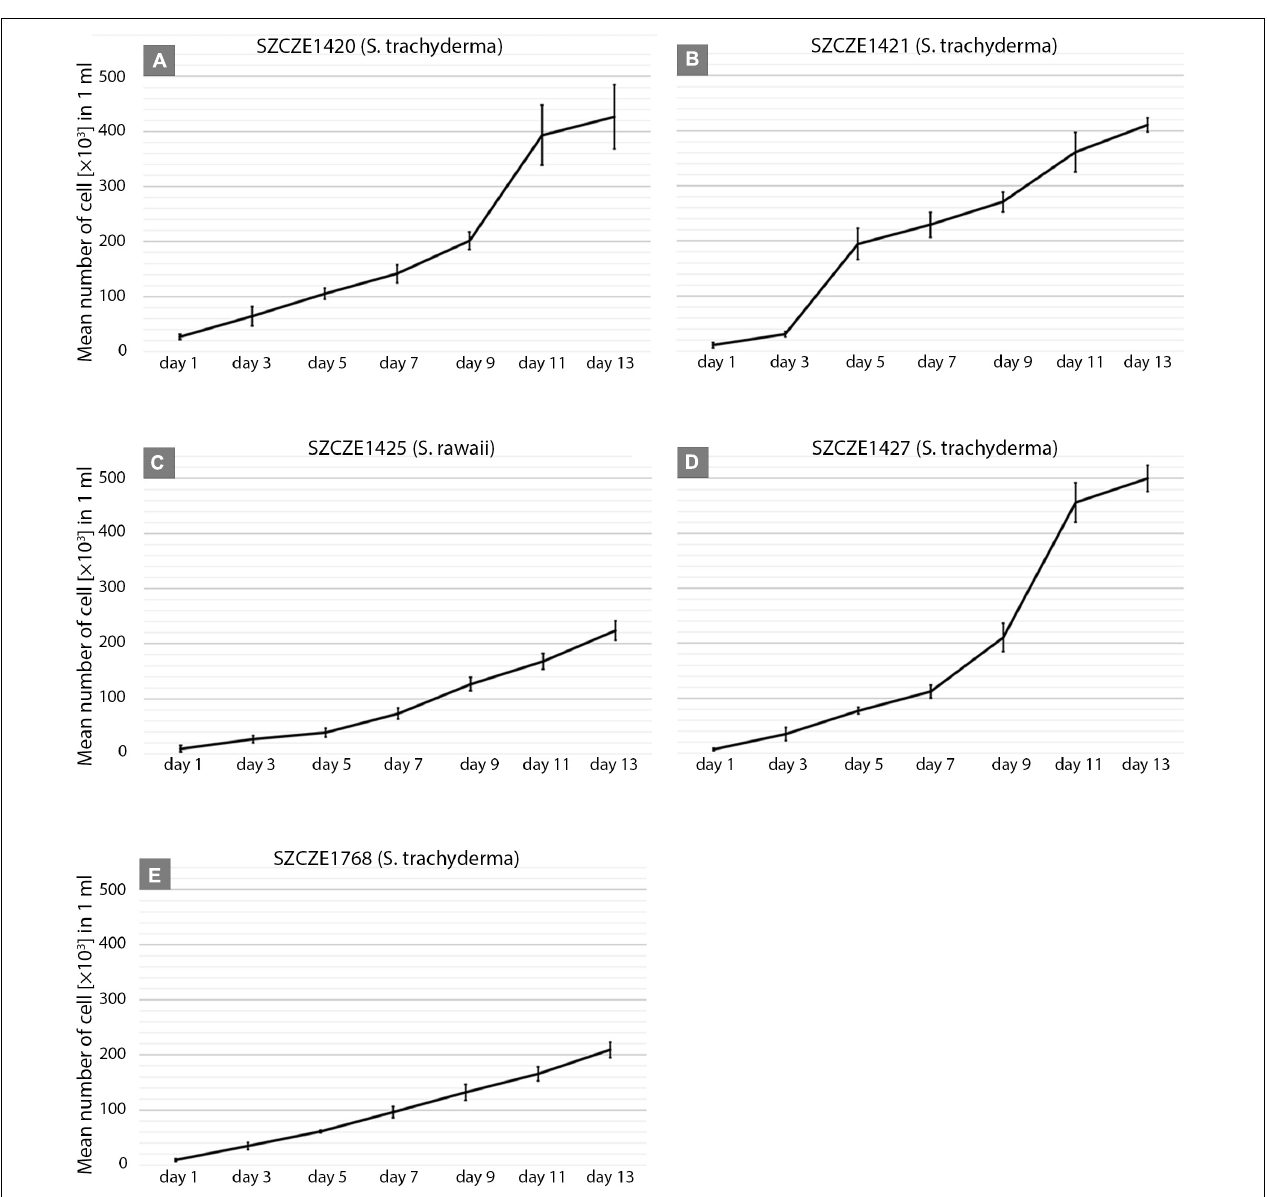
FIGURE 3 | (A–E) Growth curves of Schizostauron spp. strains, based on a mean value calculated from triplicates. Error bars represent standard